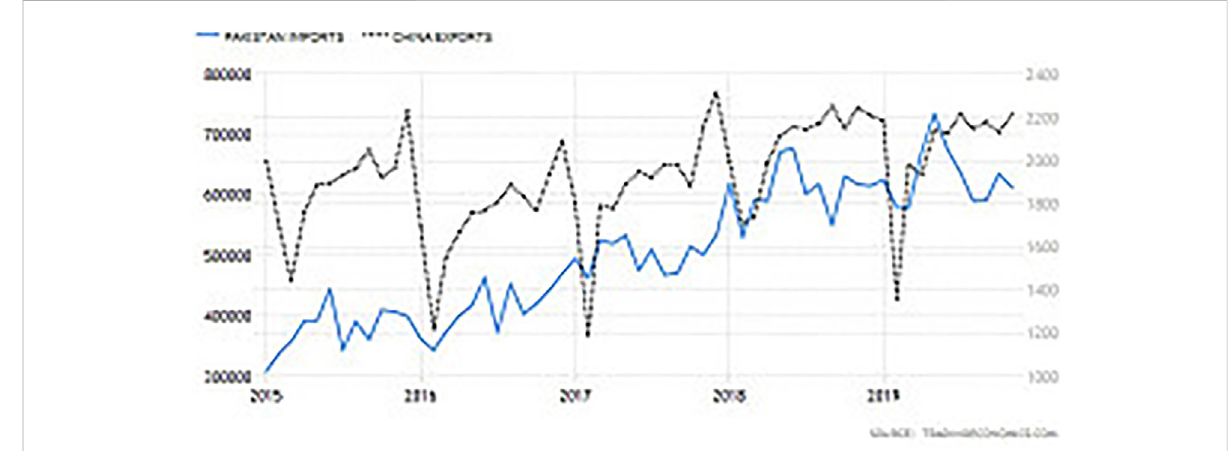
FIGURE 1 Trade balance between Pakistan and China (Source:tradingeconomics.com).